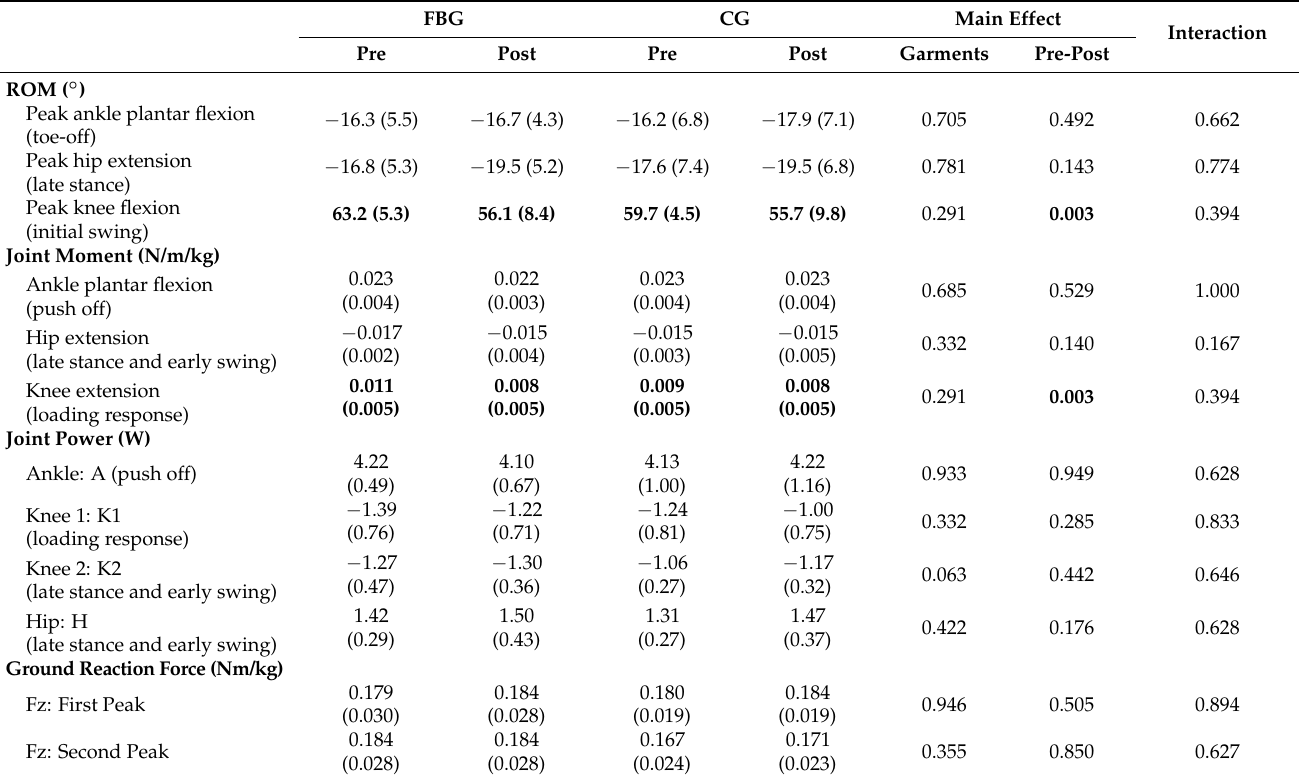
Table 5. Kinematics, Kinetics data and Ground reaction force during walking under two garments condition, i.e., effect of wearing comparison FBG and CG, average (SD), two-way ANOVA, p values < 0.05 are bolded.